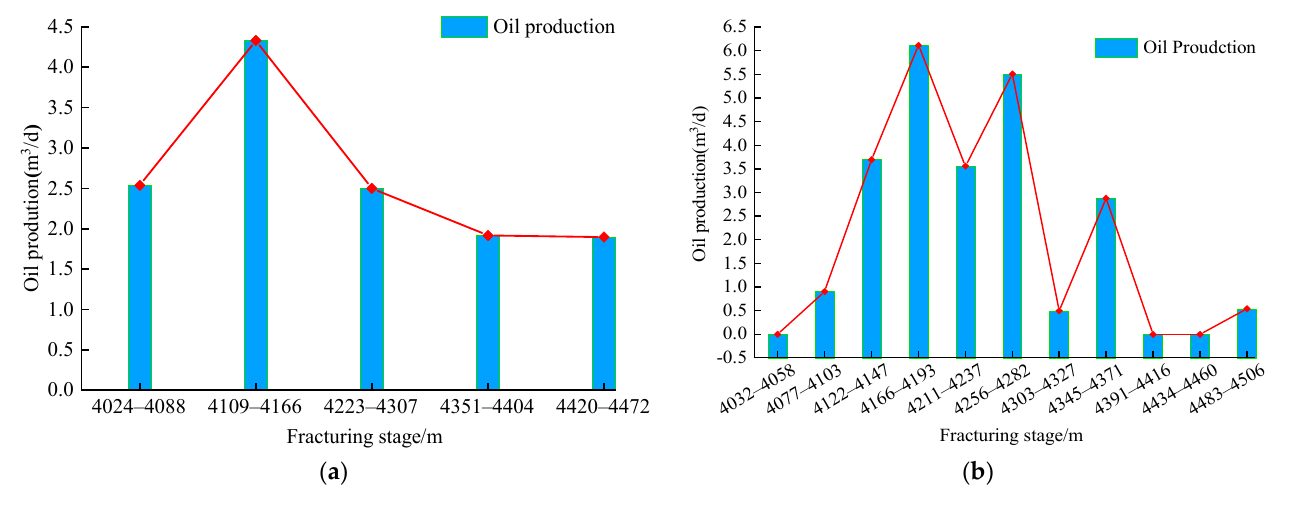
Figure 10. Oil production: ( a ) the oil production of well A; ( b ) the oil production of well B.